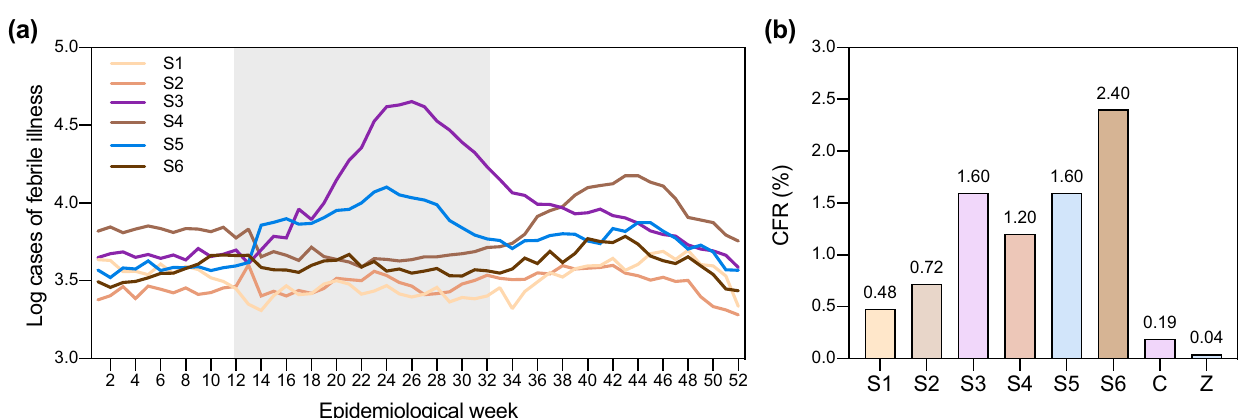
Fig. 5 Reported febrile illness cases and case fatality rates of dengue cases during inter-dengue outbreak periods exceeded those reported during dengue outbreaks. a Temporal trends in weekly febrile illness cases re fl ect temporal trends in reported dengue, chikungunya, and Zika cases. Acute febrile illness cases reported by epidemiological week per municipality were obtained from the National Statistics Directorate of the Ministry of Health (saip.gob. do). Weekly cases were aggregated to the national level. Chikungunya and Zika outbreak peaks are denoted by the gray box. b Percent case fatality rates (CFR) for dengue cases rose during seasons in which no dengue outbreak was reported. CFRs were calculated for six seasons of reported dengue cases (S1 – S6) and two seasons of emerging disease cases (chikungunya (C) and Zika